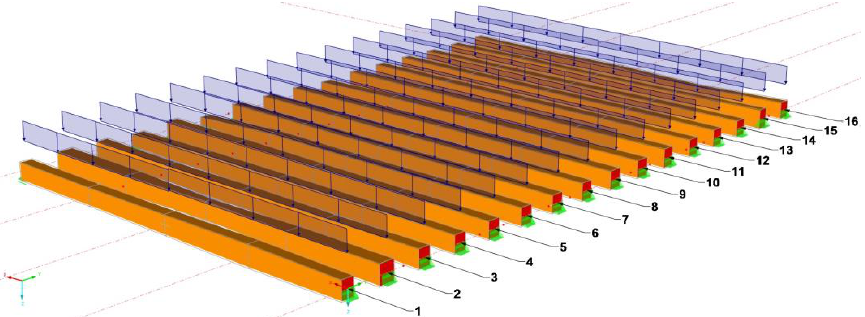
Figure 14. Modelling of the wooden floor with the assigned number and simulated loads of the 16 beams.